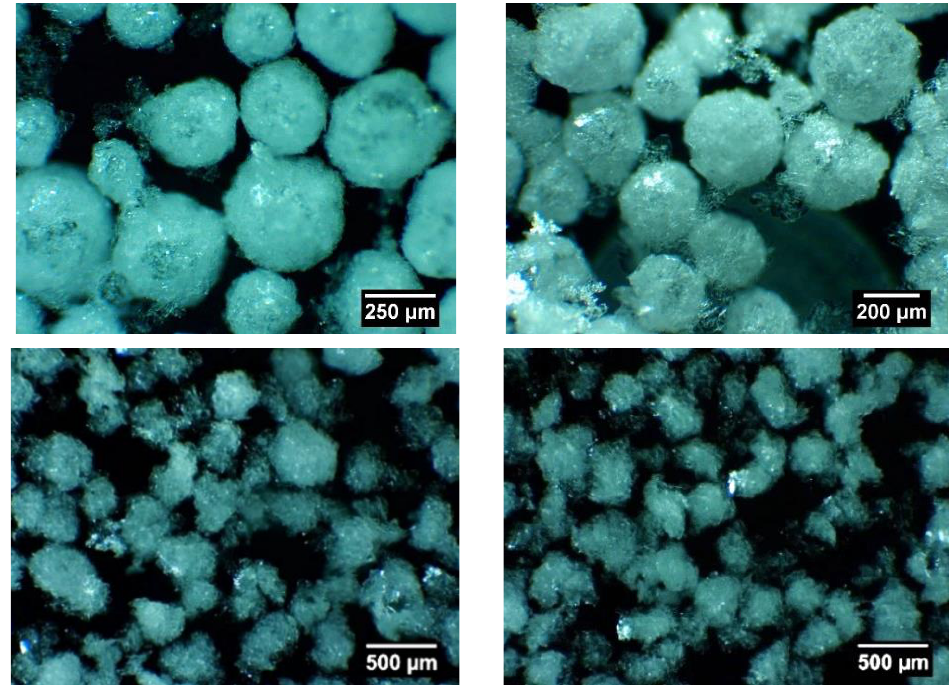
Figure 3. BA SAs at comparable mixing conditions — 800RPM, flux = 240 Lm −2 h −1 , BSR = 0.8, d p = 18 µm, formed in a ( top ) flat membrane dispersion cell and ( bottom ) cylindrical membrane in vibrating module.